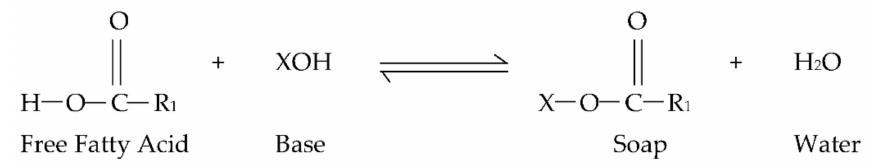
Figure 2. A schematic representation of the saponification reaction.